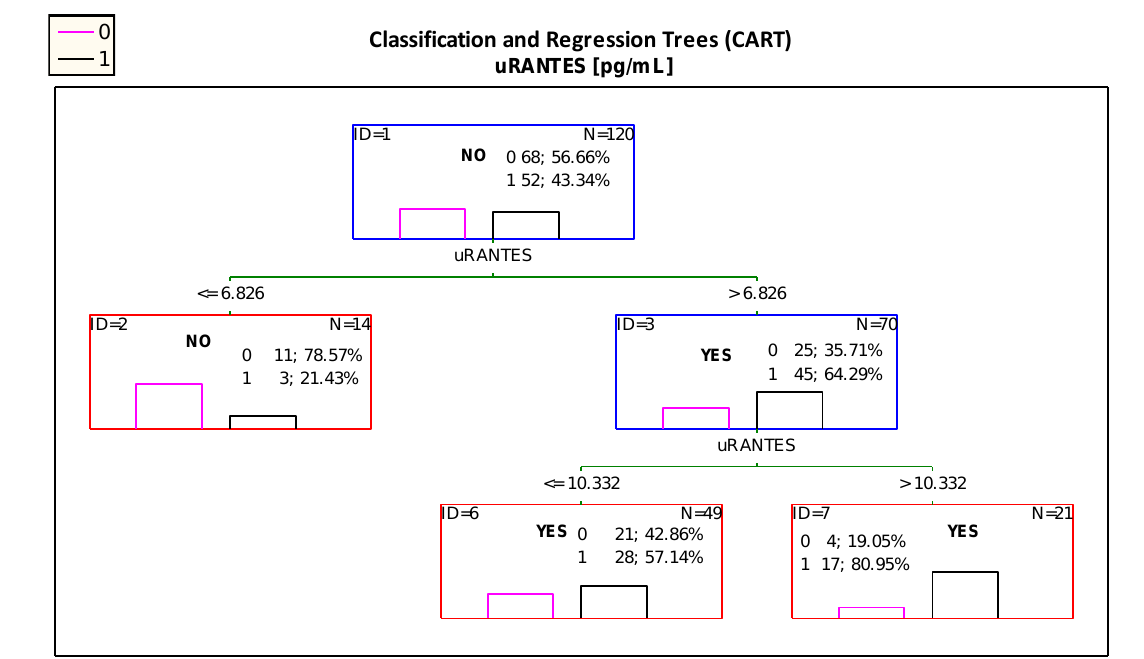
Figure 4. Classification tree for impaired renal function (albuminuria and/or decreased eGFR < 90 mL/min/1.73 m 2 and/or